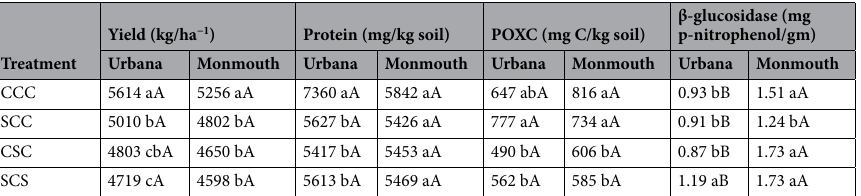
Table 1. Means of soybean yield, soil protein, permanganate-oxidizable carbon and β-glucosidase affected by crop rotation. Crop rotation: CCC (continuous corn), SCC (2 years corn), CSC (1 year corn) and SCS (1 year soybean). Means within the same column followed by different lower-case letters are significantly different at P < 0.05 for rotation. Means within the same row followed by different capital letters are significantly different at P < 0.05 for the two